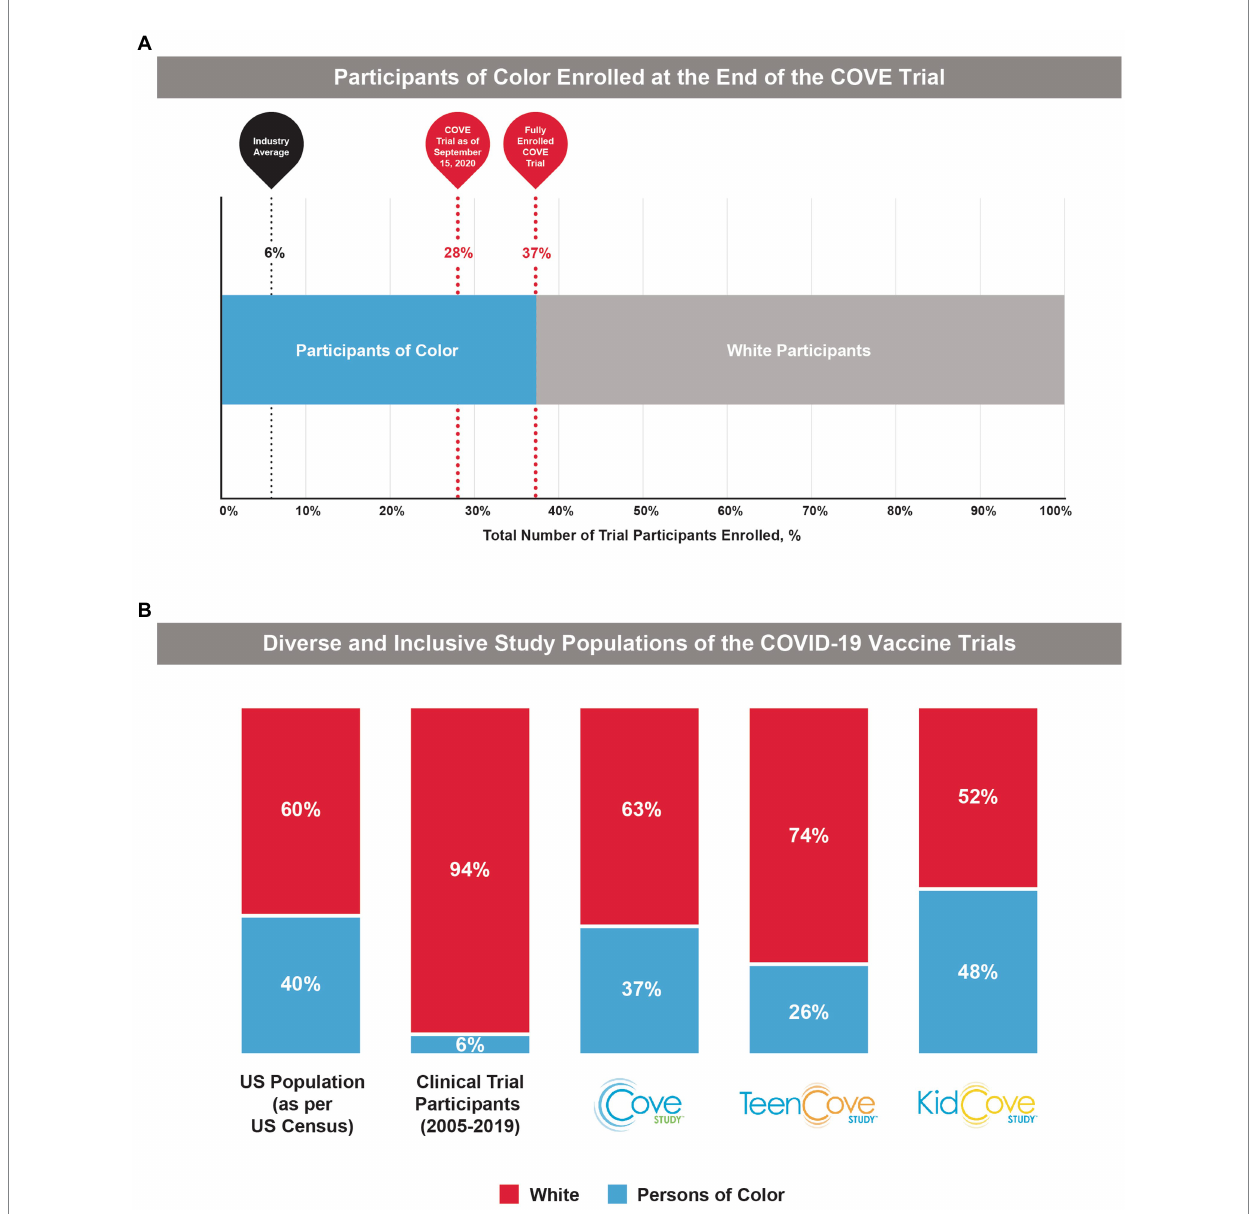
FIGURE 2 Participant demographics in the COVE, TeenCOVE, and KidCOVE studies. (A) The percentage of Participants of Color enrolled in the COVE trial increased after pivoting from initial strategies, but notably was above the industry standard (6%) even at earlier trial timepoints. (B) In comparison to previous clinical trial populations from 2005 to 2019 (10), the phase 3 mRNA-1273 studies (COVE, TeenCOVE, and KidCOVE) were representative of demographics for Persons of Color in the United States (9). Persons of color were defined as individuals who identify as, but not limited to, Native American, Alaska Native, Indigenous, Latinx, Hispanic, Asian, Pacific Islander, African American, Black, Middle Eastern, and two or more